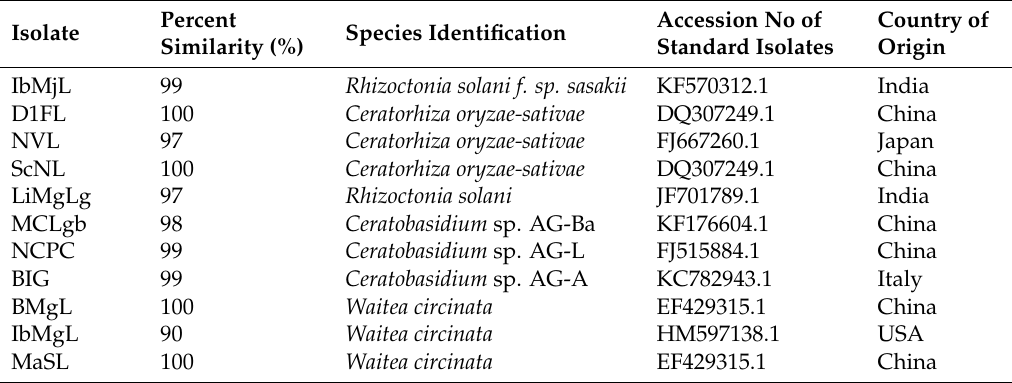
Figure 7. Digital image of ITS products of different Rhizoctonia spp. showing bands of approximately 650–700 bp. Suspected R. solani isolates produced a single band of ~700 bp, while the suspected R. oryzae and three binucleate Rhizoctonia isolated from other hosts produced a single band of ~650 bp. Table 3. Mega Basic Local Alignment Search Tool (BLAST) search results of the deduced ITS sequences using National Center for Biotechnology Information (NCBI) GenBank. database for species identification.